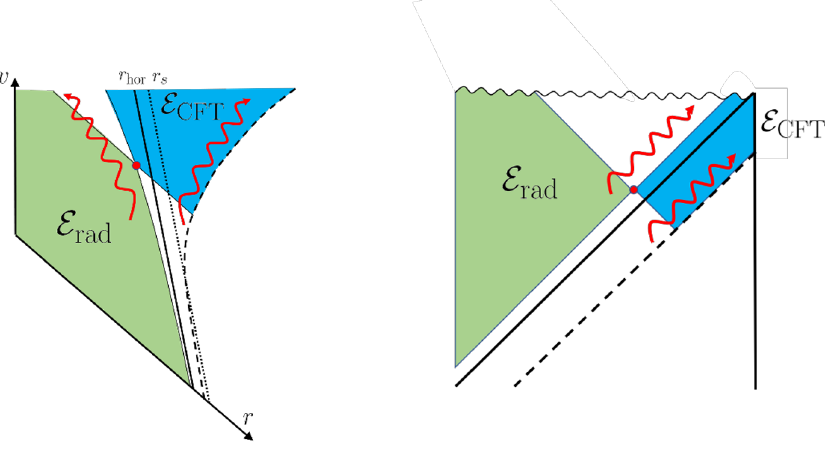
Figure 7. The next Hawking modes to escape the black hole and be extracted into H rad will be entangled with interior modes that are mostly in the entanglement wedge of the reservoir H rad . This causes the entanglement between the black hole and the reservoir to decrease as the new radiation is extracted, in accordance with the Page curve. (Left: Eddington-Finkelstein coordinates; right: a Penrose